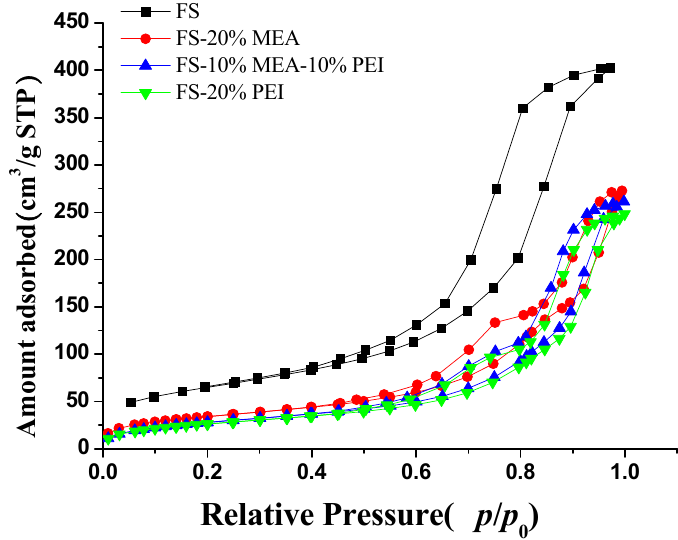
Figure 3. N 2 adsorption–desorption isotherms.